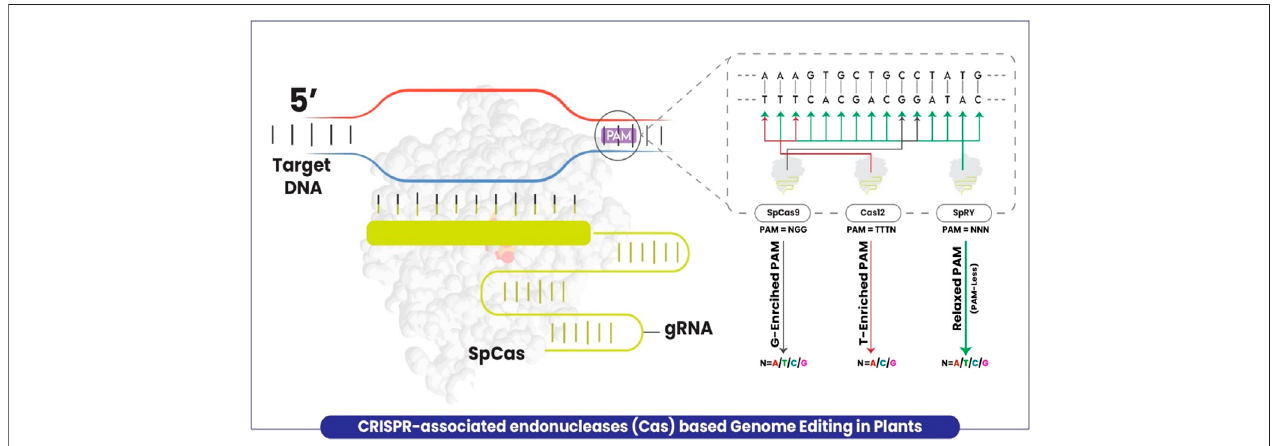
FIGURE1| Aschematicmodel explainingthe plantgenome editingusing CRISPR-associated enzymes withlimitationsand extrafeature ofSpRY ascomparedto others. Cas9 targets a G enriched site with PAM = NGG (Black arrow), Cas12 targets T enriched site with PAM = TTTV (Red arrow), whereas SpRY with no PAM restriction (Green arrow).